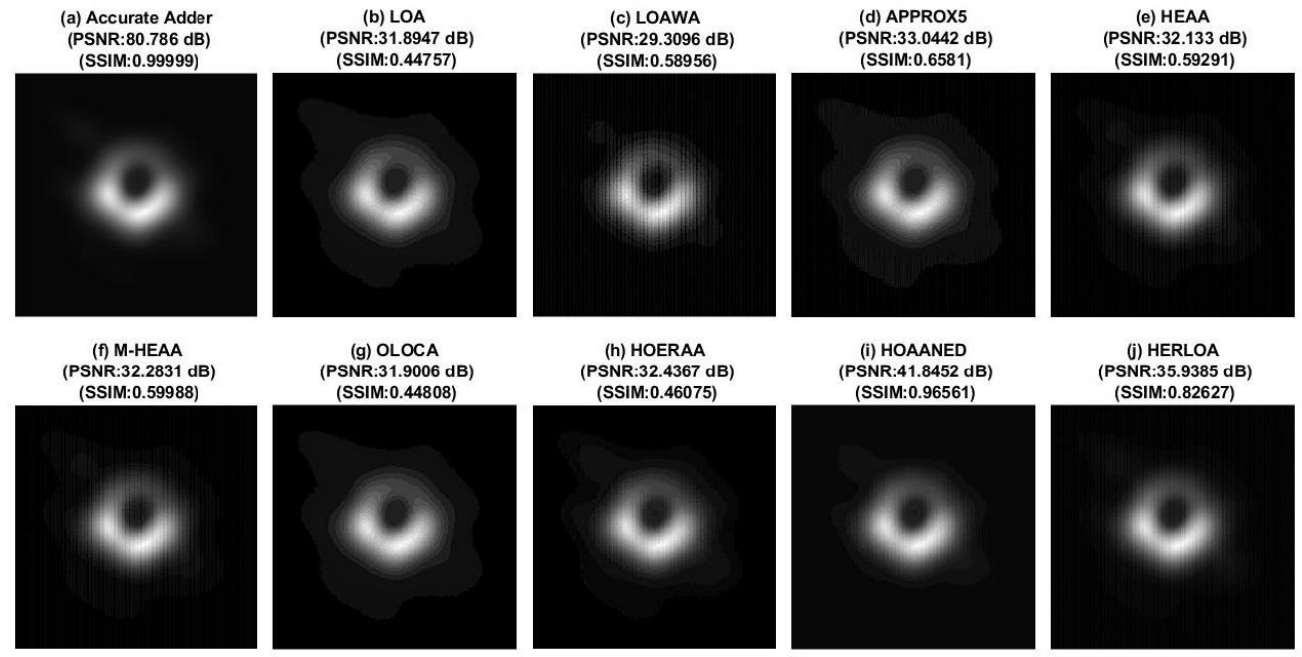
Figure 10. Black Hole image compressed using accurate adder and different approximate adders, with the approximate adders having an 11-bit inexact part.